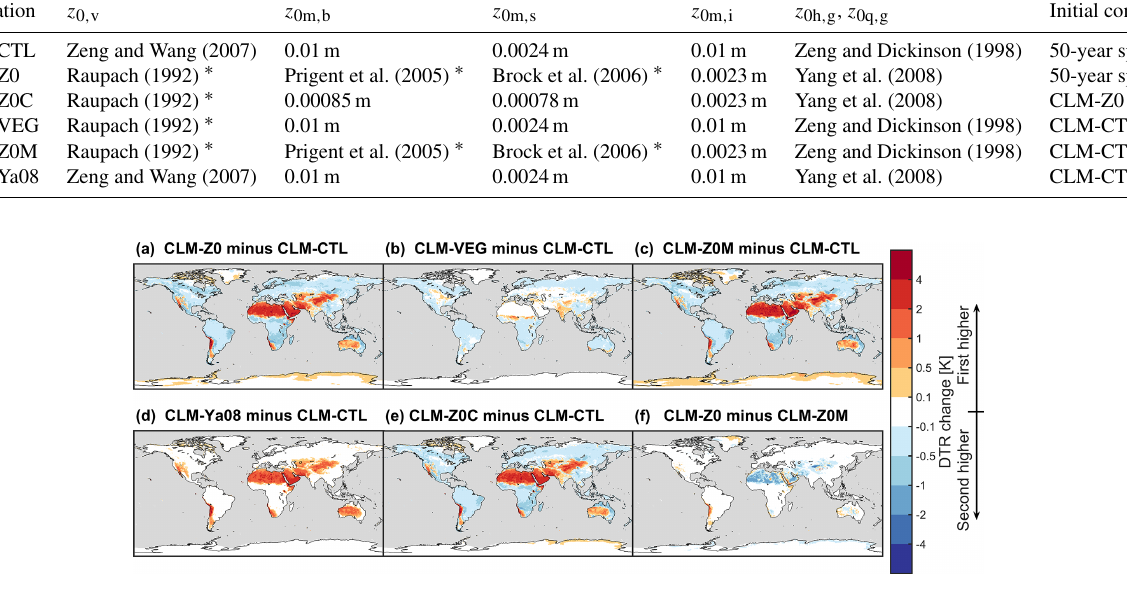
Figure A1. Difference in LST DTR over 2003–2012 for (a) CLM-Z0 minus CLM-CTL, (b) CLM-VEG minus CLM-CTL, (c) CLM-Z0M